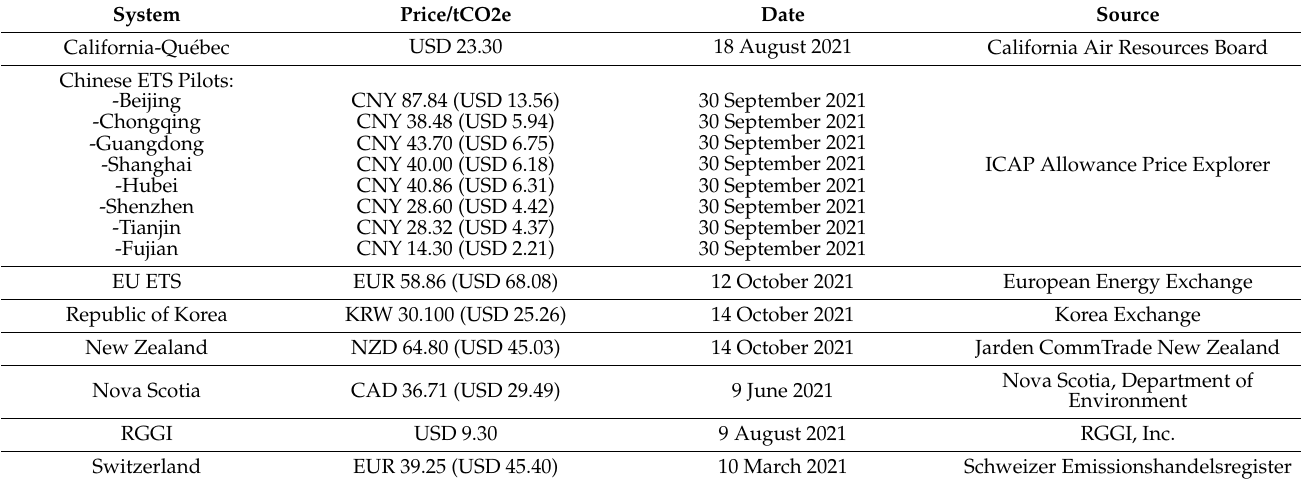
Table 8. Values of carbon units in the voluntary and regulated